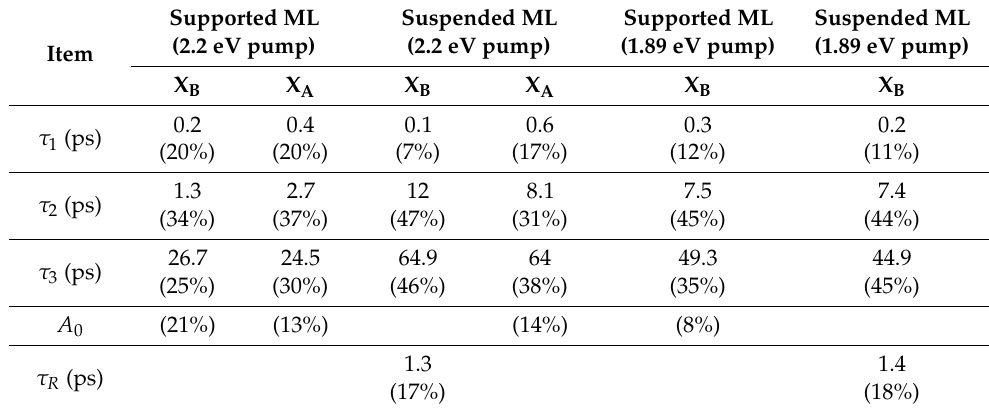
Table 3. Fitted decay parameters for supported and suspended monolayer MoS 2